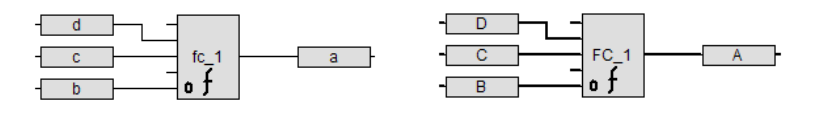
Figure 7. Function invocation: (bit) a = fc_1 (b,false,c,d) (Word) A = FC_1(B,0,C,D).